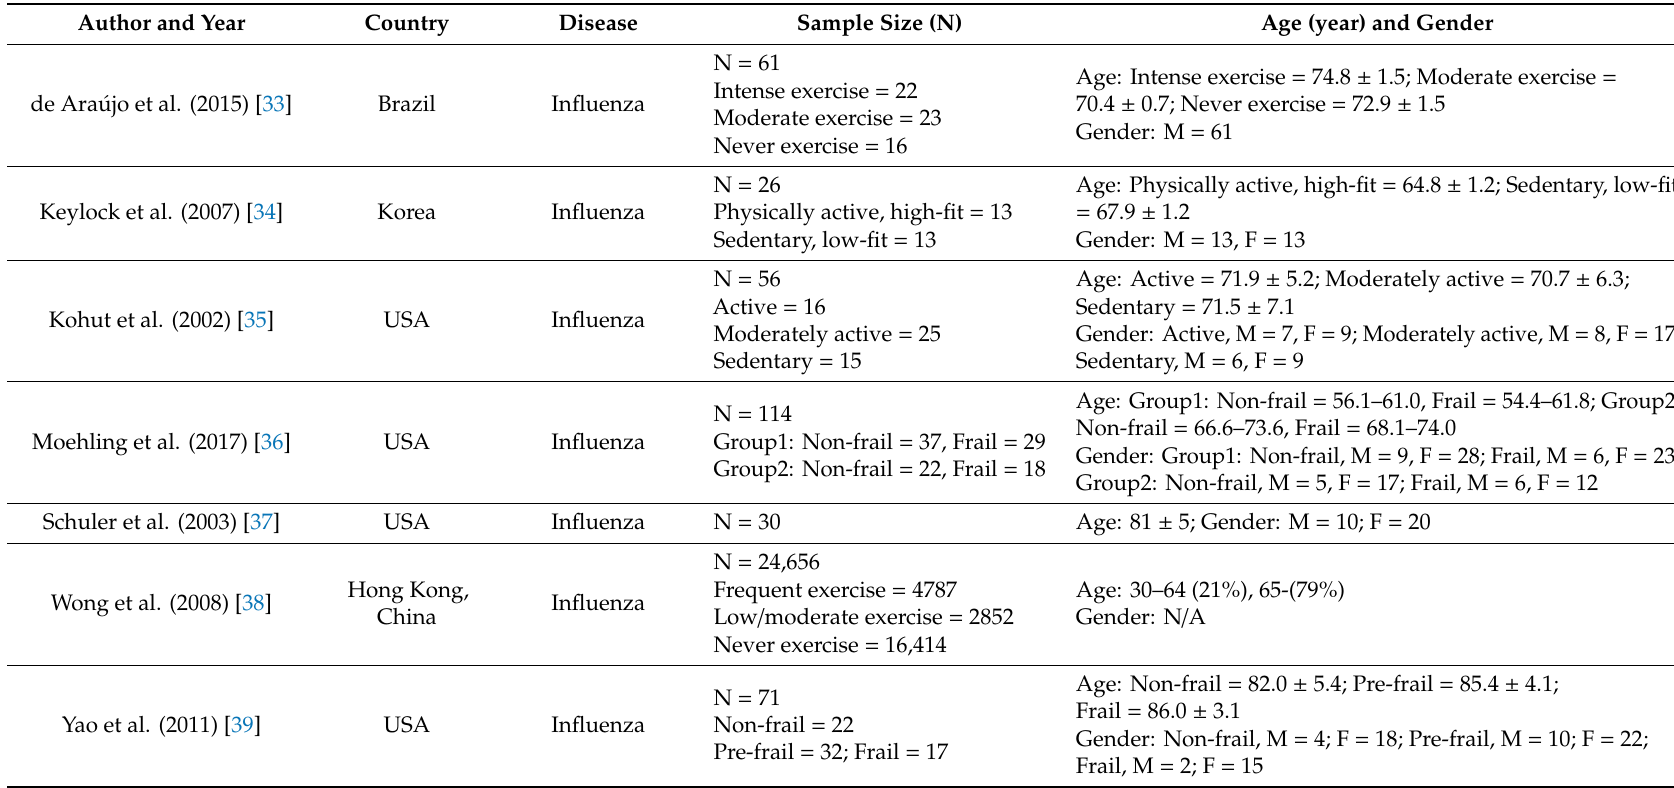
Table 2. The study characteristics of cross-sectional and observational